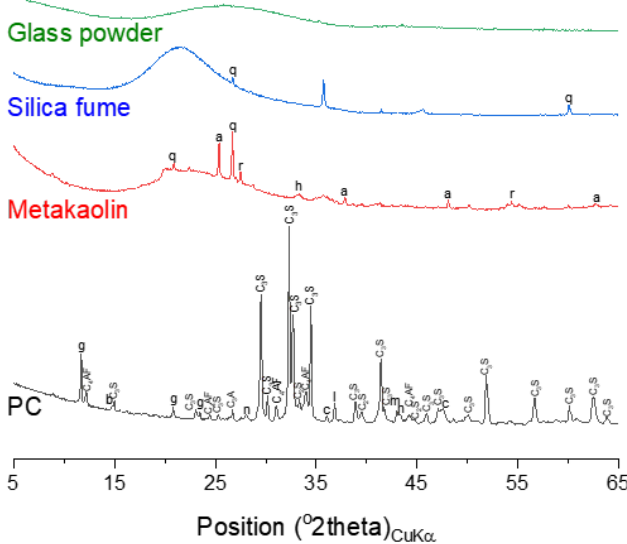
Figure 1. X-ray diffraction (XRD) patterns of raw materials. The following symbols are used to denote: a — anatase, b — bassanite, c — calcite, g — gypsum, h — hematite, n — thernadite, m — periclase, q — quartz, r — rutile.